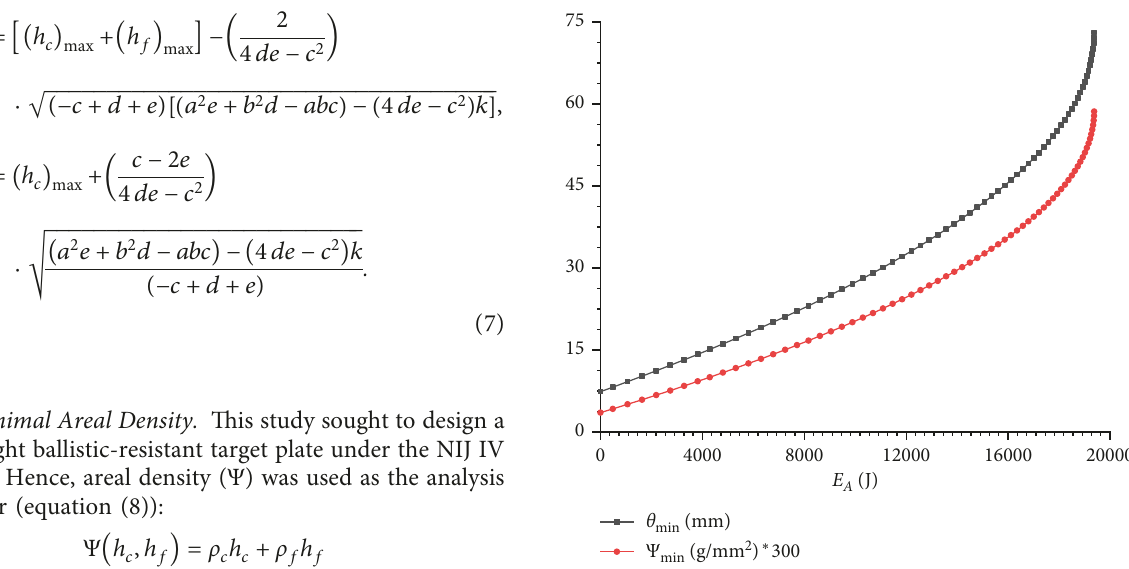
Figure 6: Absorptive energy corresponded to minimization of thickness and areal density of the